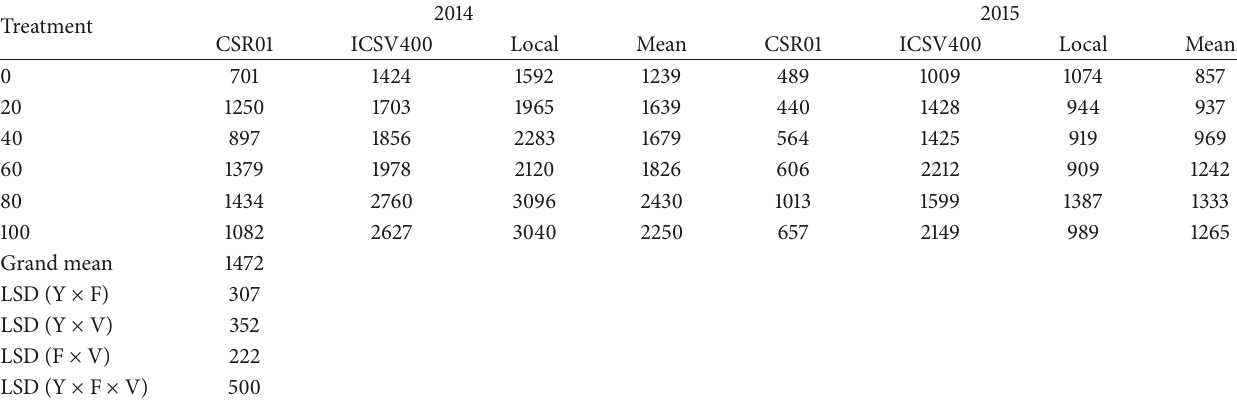
Table 4: Effects of year, N-fertilizer, and variety on sorghum grain yield Minjibir.